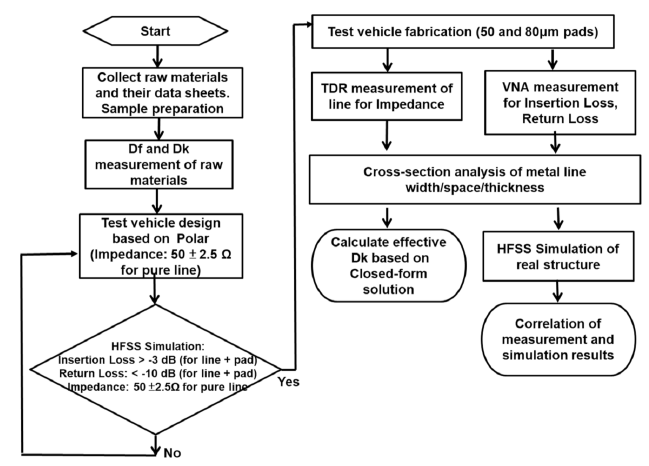
Figure 1. Flowchart of dielectric materials